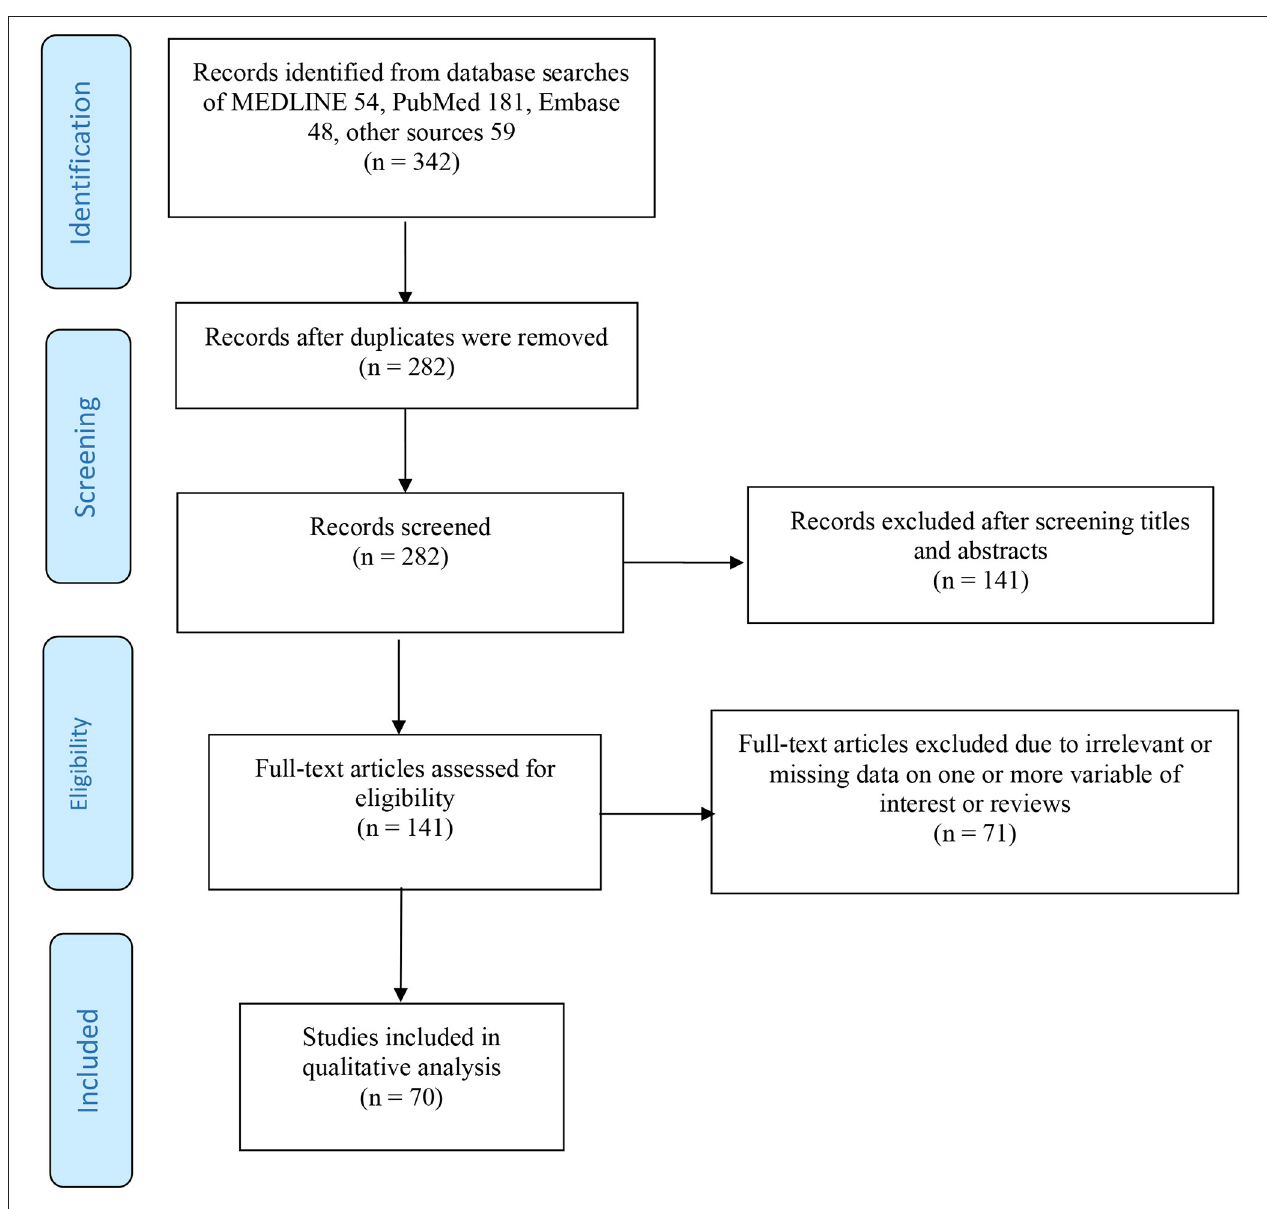
FIGURE 1 | Flow diagram of the searching strategy and article selection